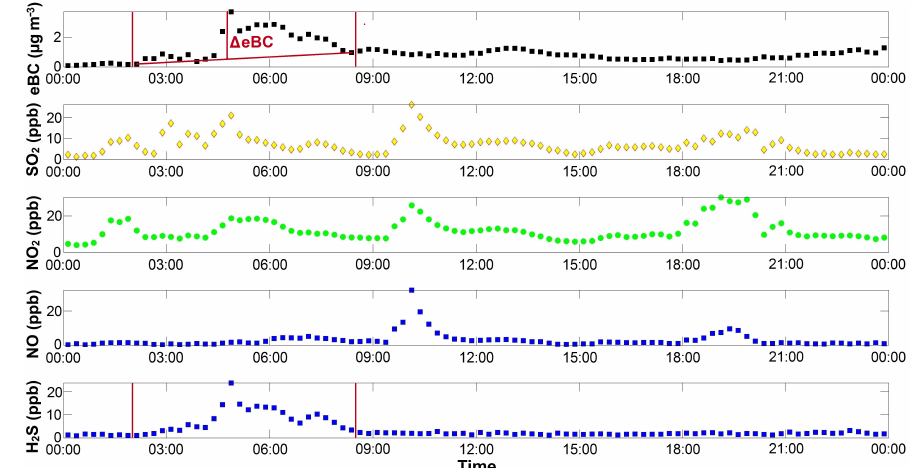
Figure 3. Example to illustrate how species were correlated with eBC in order to separate sources from one another. The excess eBC ( (cid:49) eBC), defined as the eBC concentration above the baseline for this example, is also indicated in the top panel.